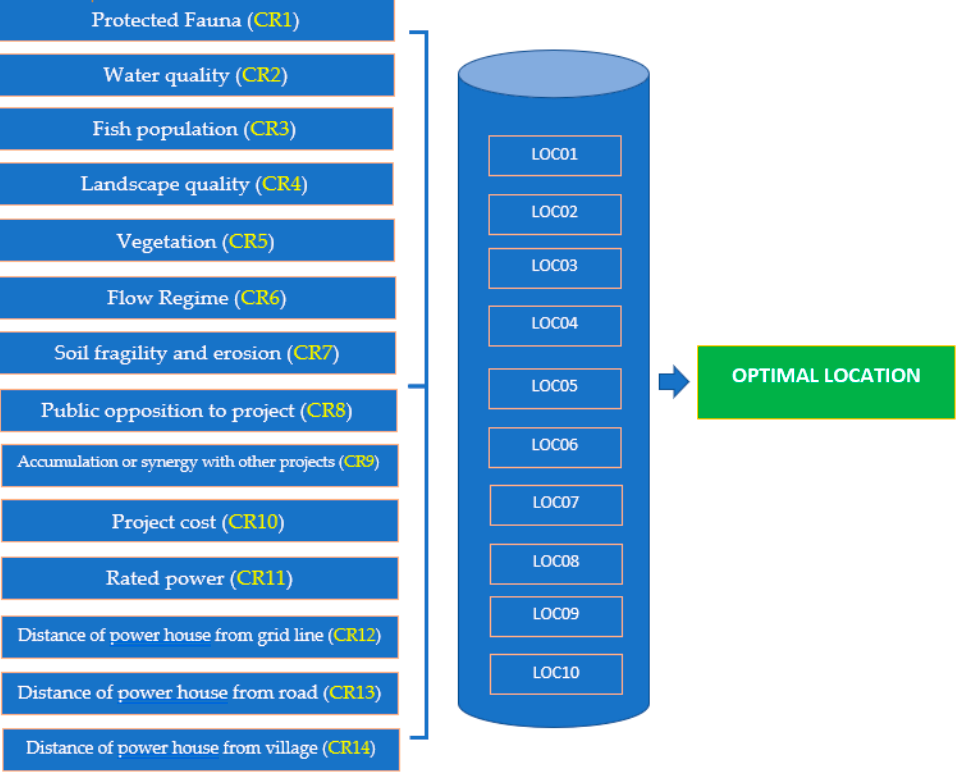
Figure 5. Criteria affecting location selection.